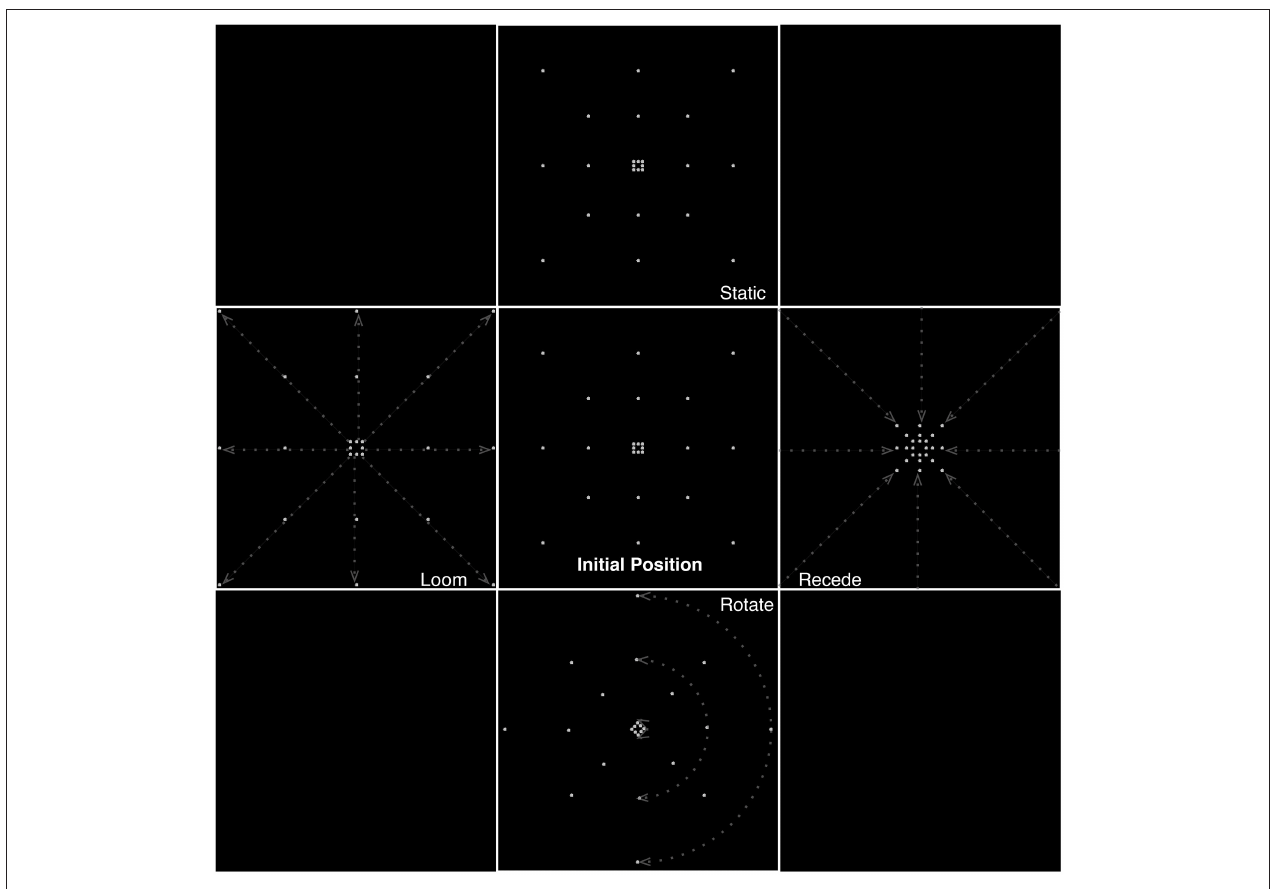
FIGURE 1 | Different types of motion presented in the experiment, illustrating frames from the static, looming, receding, and rotating conditions. Dashed lines and arrows indicate illustrative trajectories of dots for each condition. Equiluminance of the stimuli was preserved by maintaining the number of dots at any time in all conditions. In the looming conditions, dots passing the edge of the screen were replaced by dots at the center while for receding stimuli, dots disappearing to the center of the screen were replaced with dots at the edges.